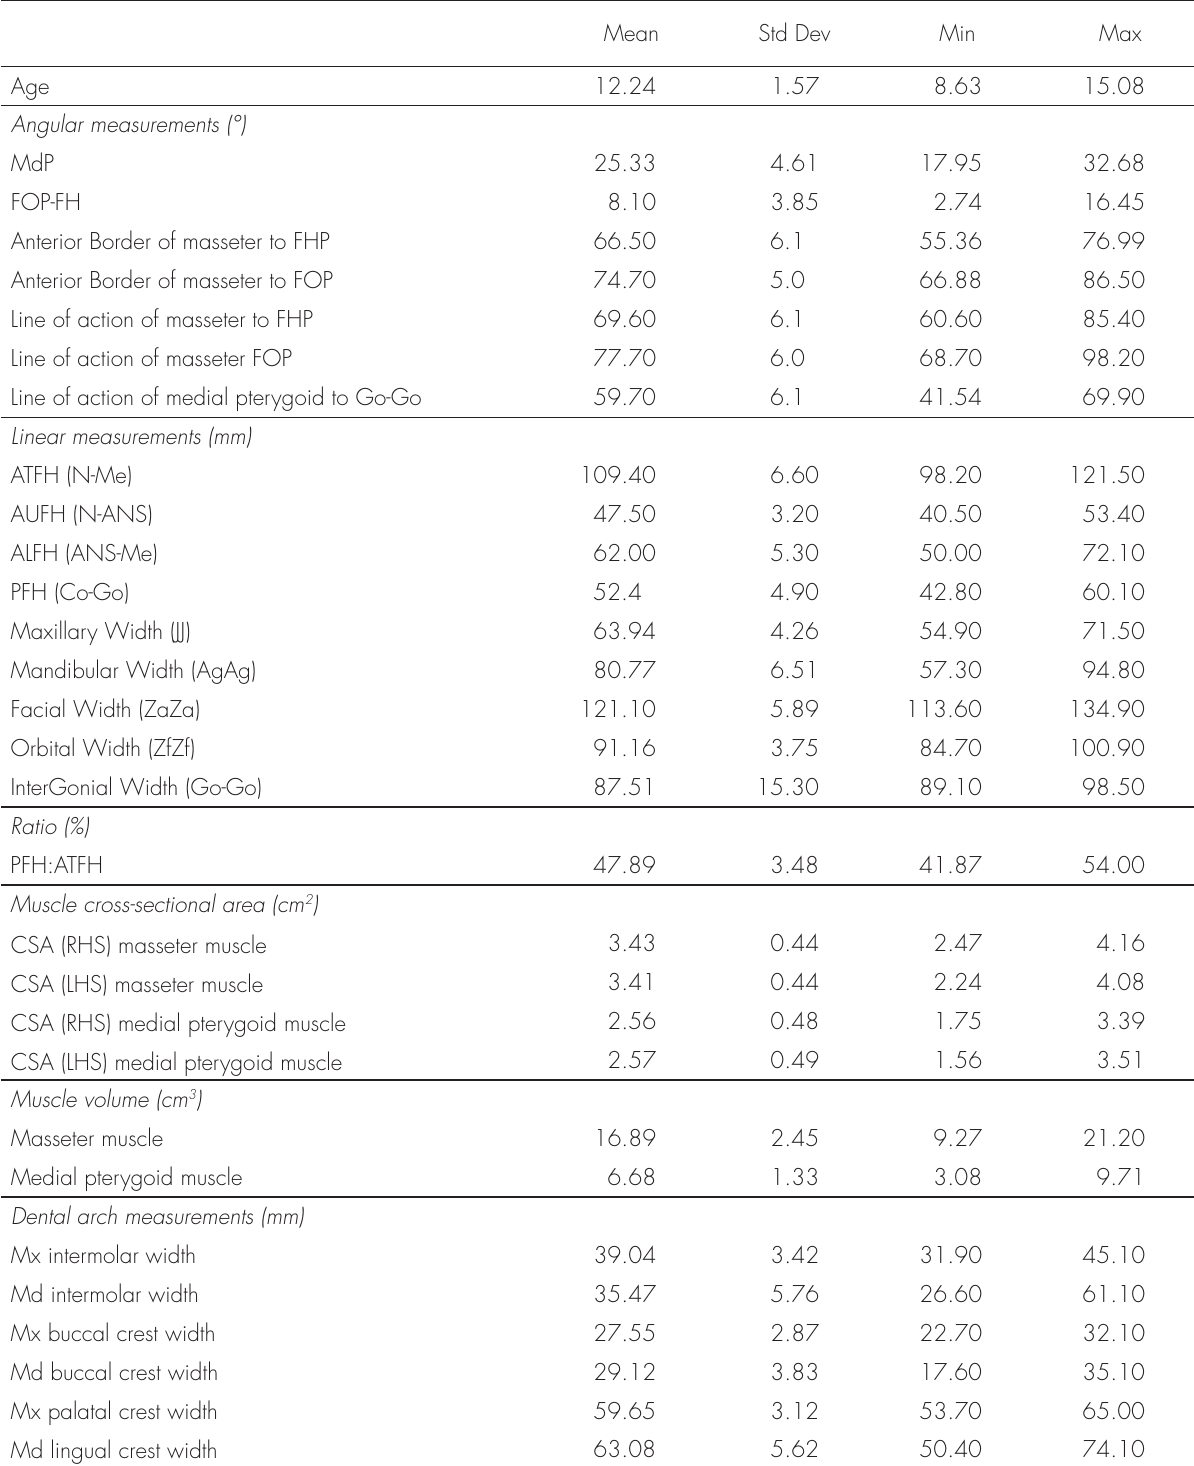
Table IV. Means for all dental, skeletal and muscular measurements for the total undivided